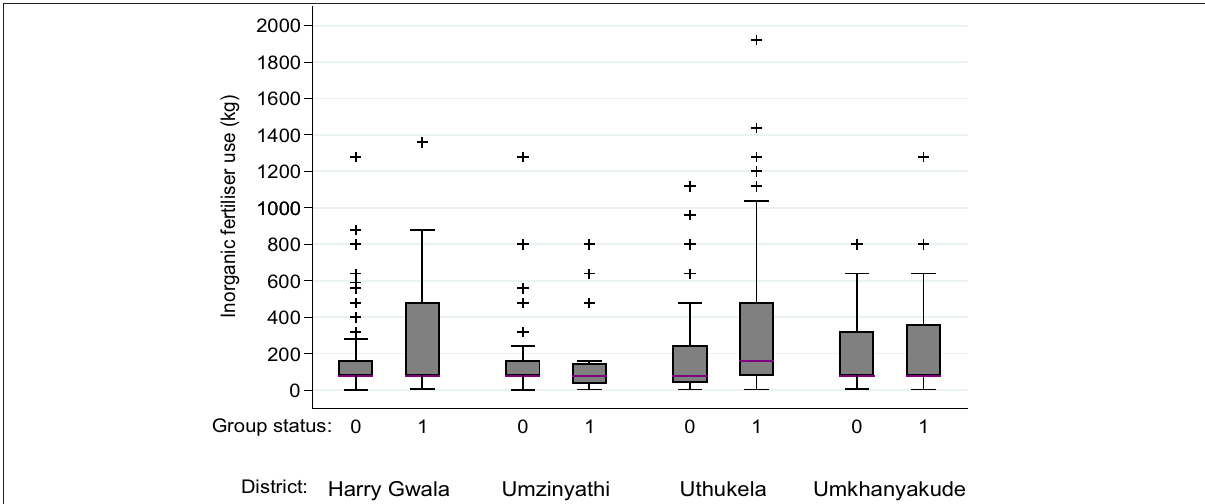
Figure 2: Box-and-whisker plots showing the quantity of fertiliser used by farmers according to district and group status: 0 indicates non-members and 1 indicates group